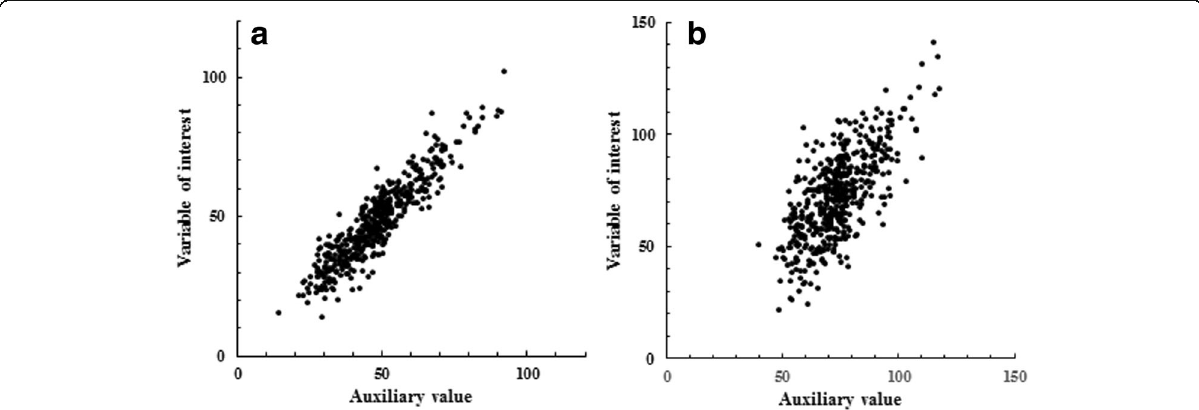
Fig. 1 Example of simulated data. The example is of stand basal area of Japanese rainforest and shows scatter plots of 500 randomly selected values of the 10,000 simulated population values of the variable of interest (target variable) plotted against the corresponding auxiliary variable values when the correlation between the two variables was a 0.9 and b 0.7. The data were generated so that the straight-line relationship between the two variables for the 10,000 data values passed through the